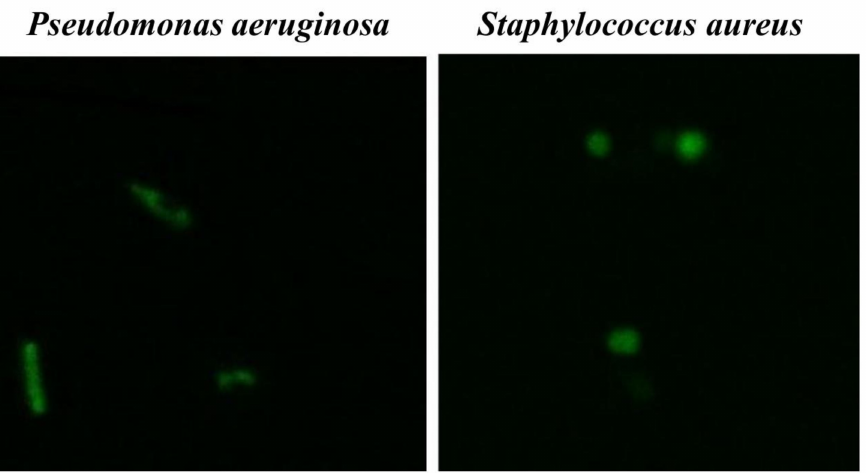
Figure 5. Pseudomonas aeruginosa ATCC 9077 and Staphylococcus aureus ATCC 6538 with FITC-labeled [CoCl 2 (dap) 2 ]Cl. Magnification 2000 ×